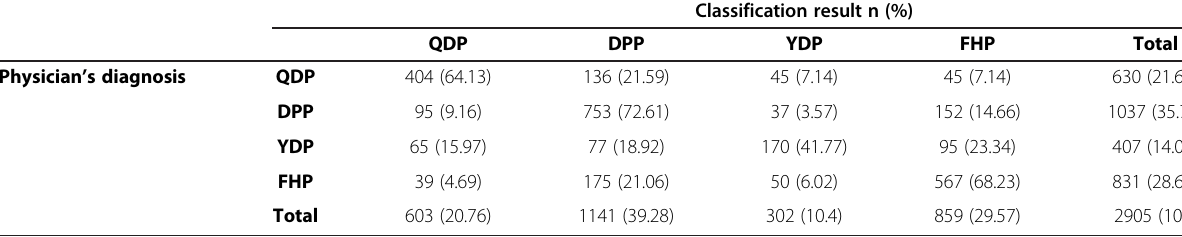
Classification result n (%) QDP